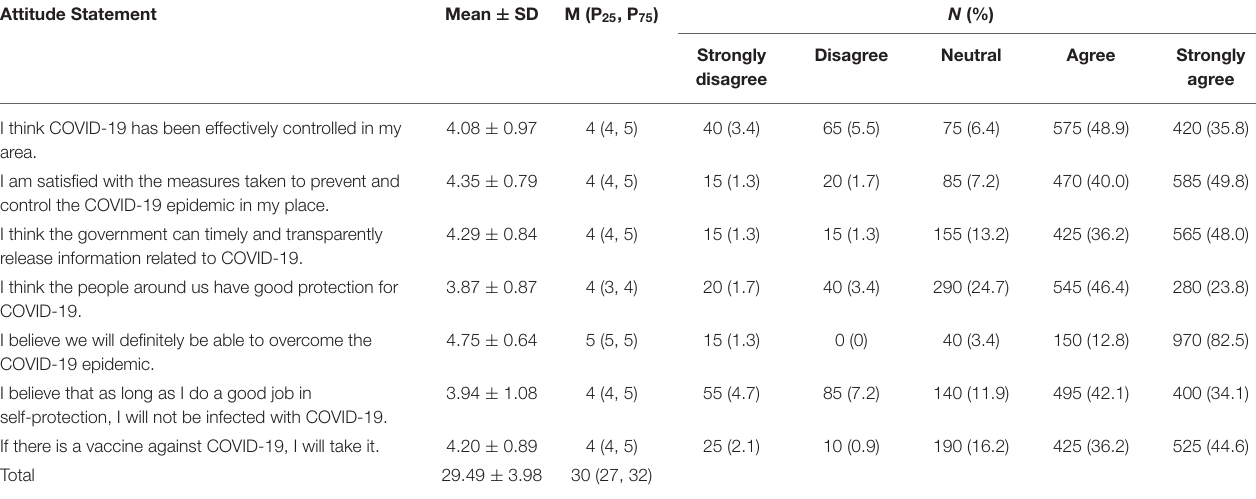
TABLE 3 | Attitudes of community residents regarding COVID-19 ( n =